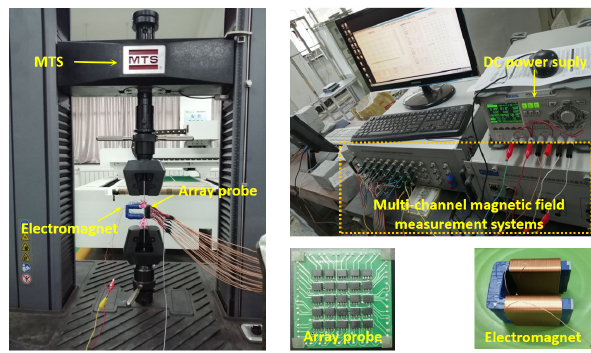
Figure 5. Experimental setup.